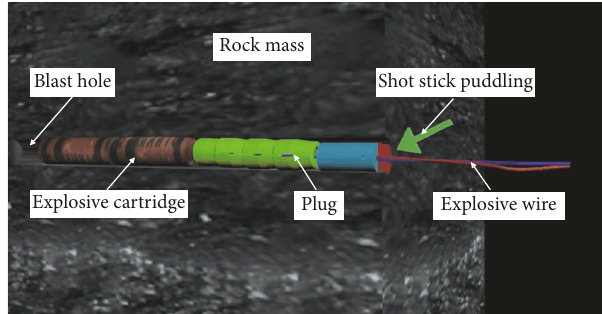
Figure 2: Schematic diagram of the blast hole plug and its location in rock